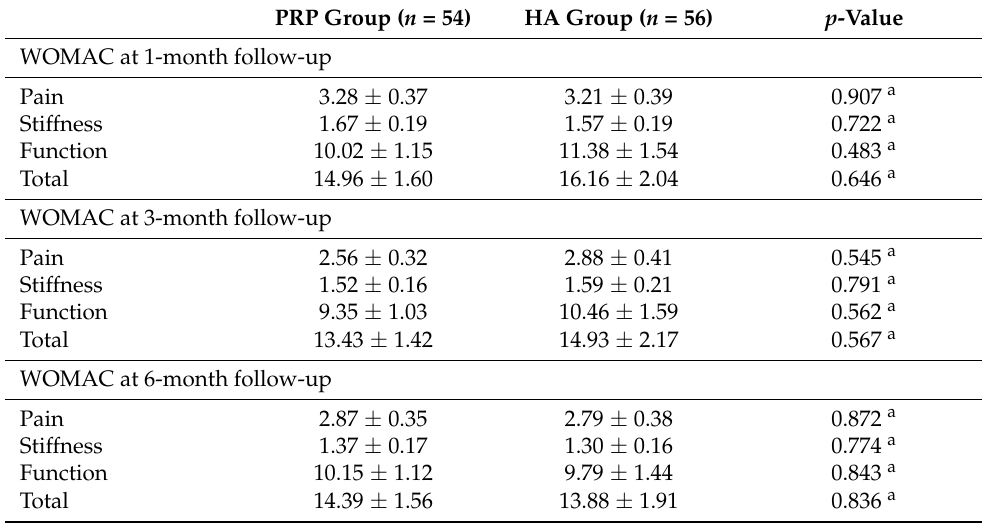
Table 2. Mean WOMAC scores at different follow-up visits in the two treatment groups.